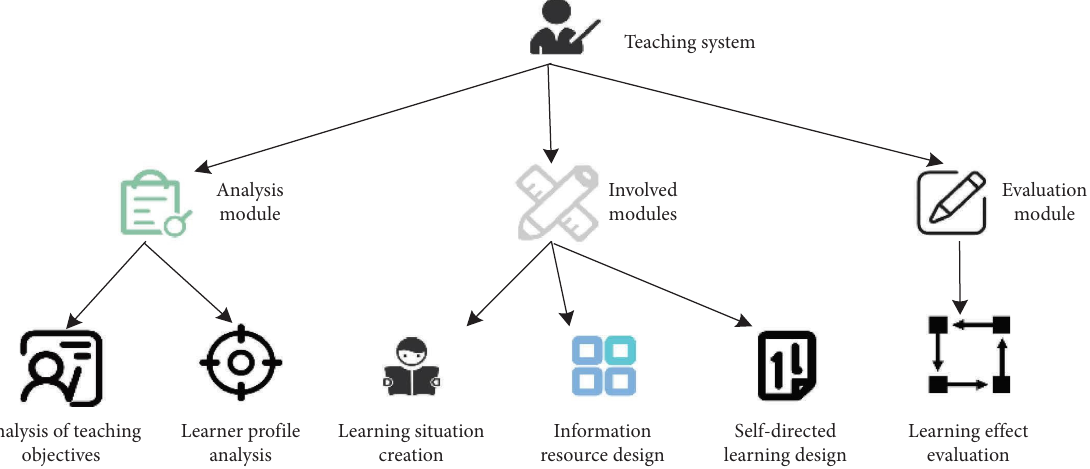
Figure 3: Instructional design of AR applied to literacy teaching in the primary